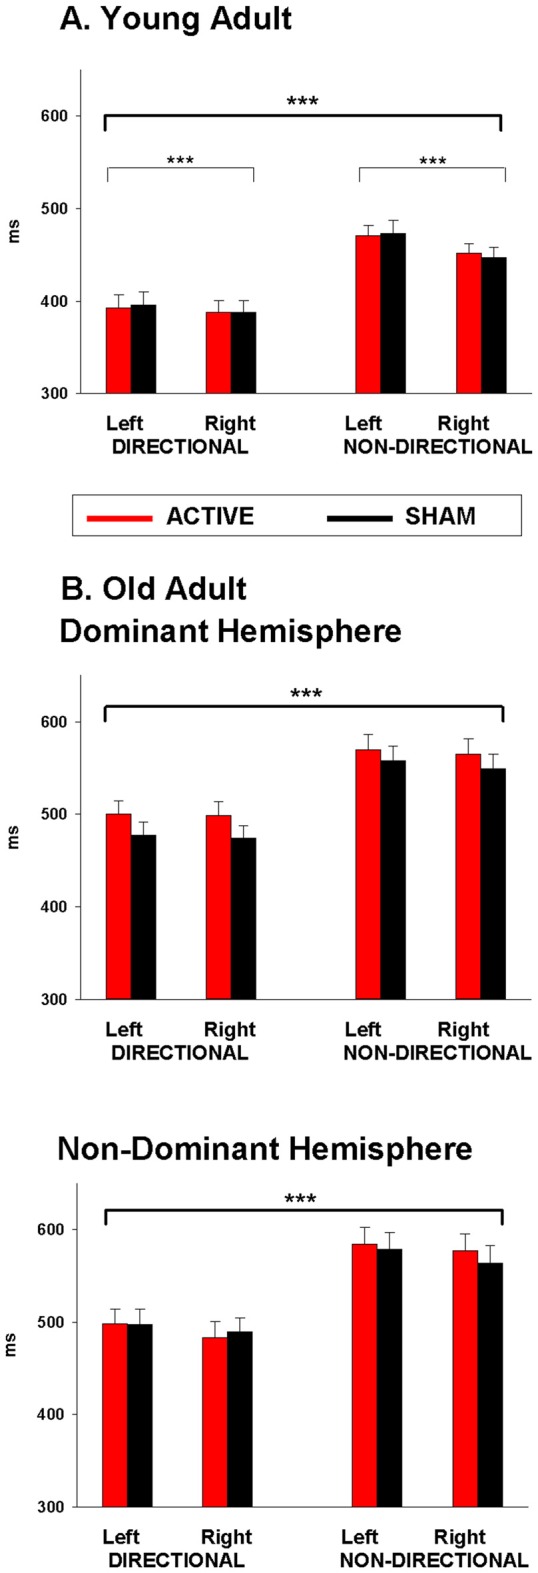
Mean response time (RT) following anodal tDCS (red) and sham (black) for (A) Young adults over dominant hemisphere, and (B) Old adults over dominant hemisphere and non-dominant hemisphere. Significant main effects are represented by asterisks (***p < 0.001).